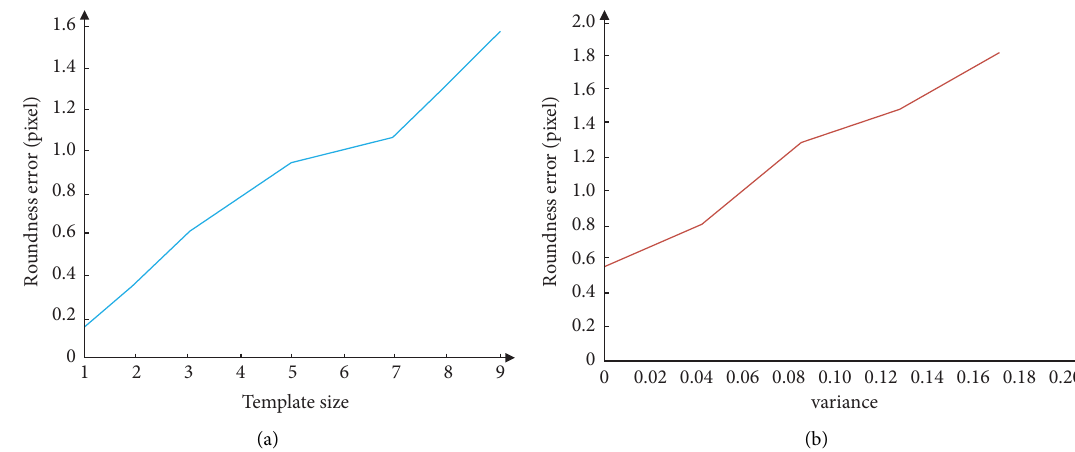
Figure 8: Roundness error diagram of the simulation image. (a) Roundness error of the simulated fuzzy flter rod image. (b) Roundness error of the simulated clear flter rod image.